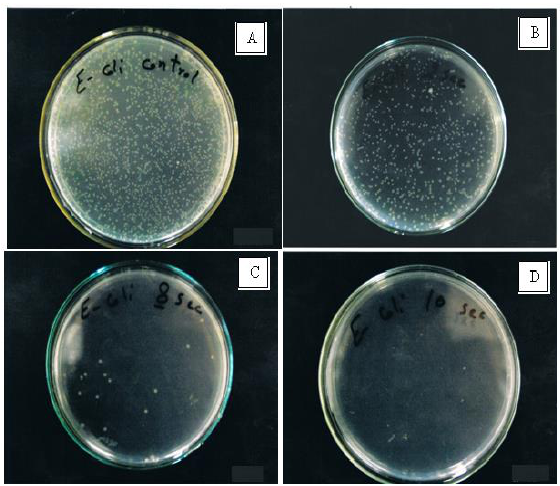
Figure(3): E.coli growth samples after exposure to plasma needle system